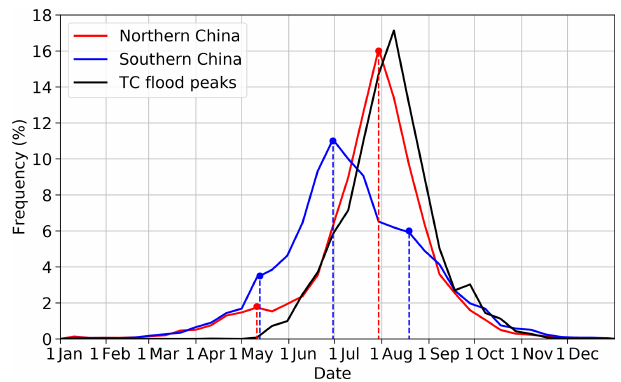
Figure 6. Seasonality of annual maximum flood peaks for northern China (red), southern China (blue), and annual flood peaks caused by tropical cyclones (black). The vertical dashed lines represent peaks of flood frequency for southern (blue) and northern China (red). In this figure, TC is used an abbreviation for tropical